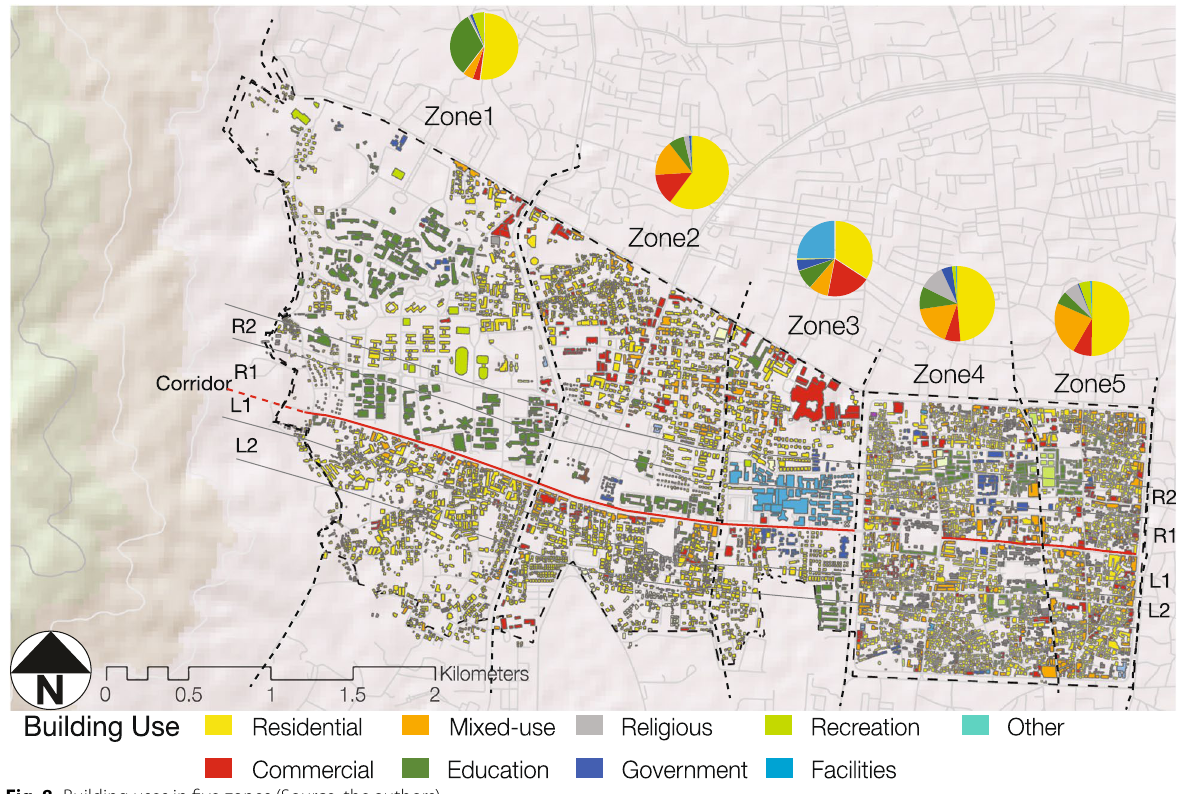
Fig. 8 Building uses in five zones (Source: the